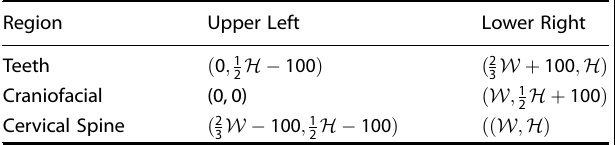
Table 7. The position of the three ARDA concentrated regions. Set the upper left corner of the LCR image as the origin of the coordinate system. Region Upper Left Lower Right Teeth Craniofacial (0, 0) W (cid:2) 100 ; 1 H (cid:2) 100 Þ ððW ; HÞ Cervical Spine ð 2 3 2 The positive x -axis is in the down direction, and the positive y -axis is in the right direction. The coordinates ( x , y ) of the upper left and lower right corners of each ARDA concentrated region. The boxes of the LCR images facing the right are mirror-symmetrical with those of the LCR images facing the